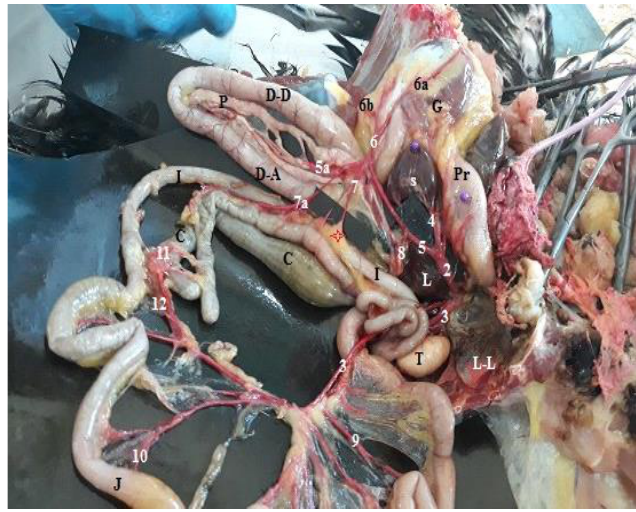
Figure 1 . Photograph illustrates the blood supply of intestinal tract. 1: Aorta, 1a: Descending aorta, 2: Celiac a, 3:Cranialmesenteric a.,4:Left ramus a., 5: Right ramus .9:Jejunal a. J :Jejunum , Pr: Proventiculus ,S: Spleen, L-L: left